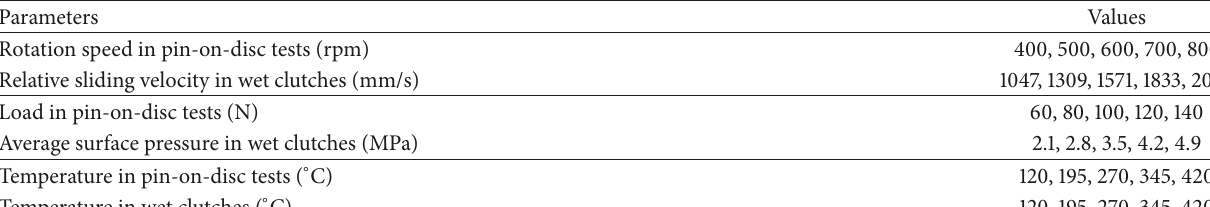
Table 1: Parameter settings in pin-on-disc tests and corresponding values in wet clutches.